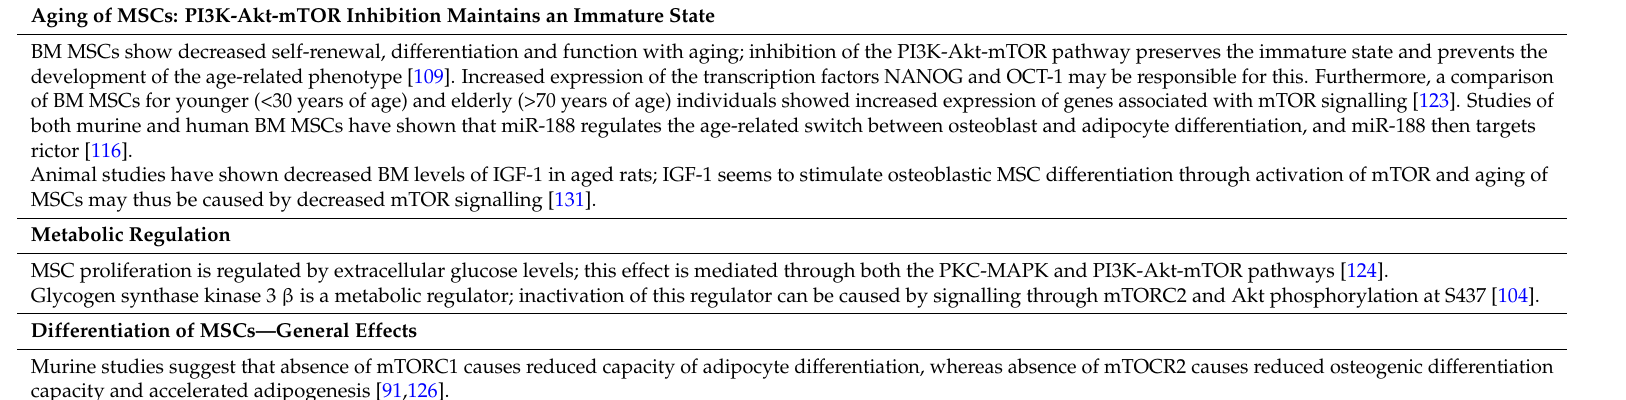
Table 3. PI3K-Akt-mTOR signalling in MSCs; the effects on important biological